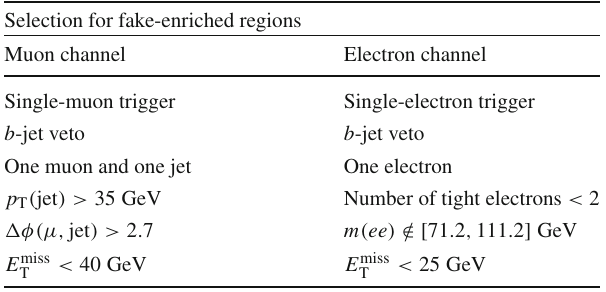
Table 4 Selection criteria defining the fake-enriched regions used to measuretheratioofthenumbersoftightandlooseleptons,theso-called fake factor, for the electron and muon